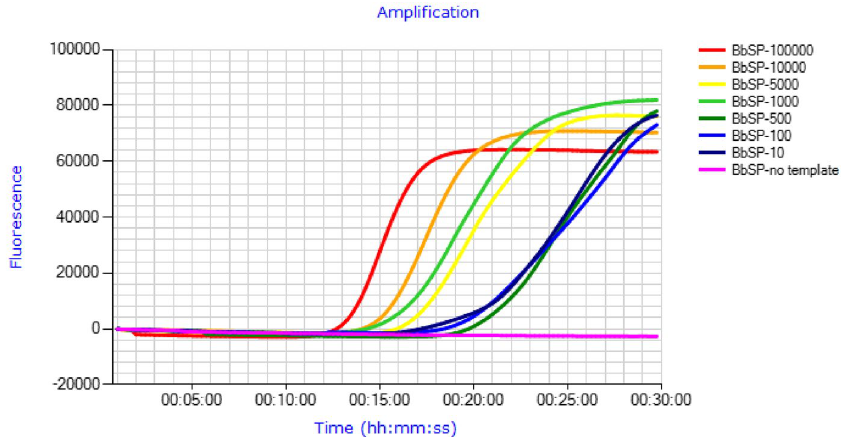
Figure 2. Detection of low levels of BBSP plasmid DNA in a background of uninfected blueberry DNA using LAMP. Templates consisted of the indicated copy numbers of BbSP cpn60 UT plasmid.